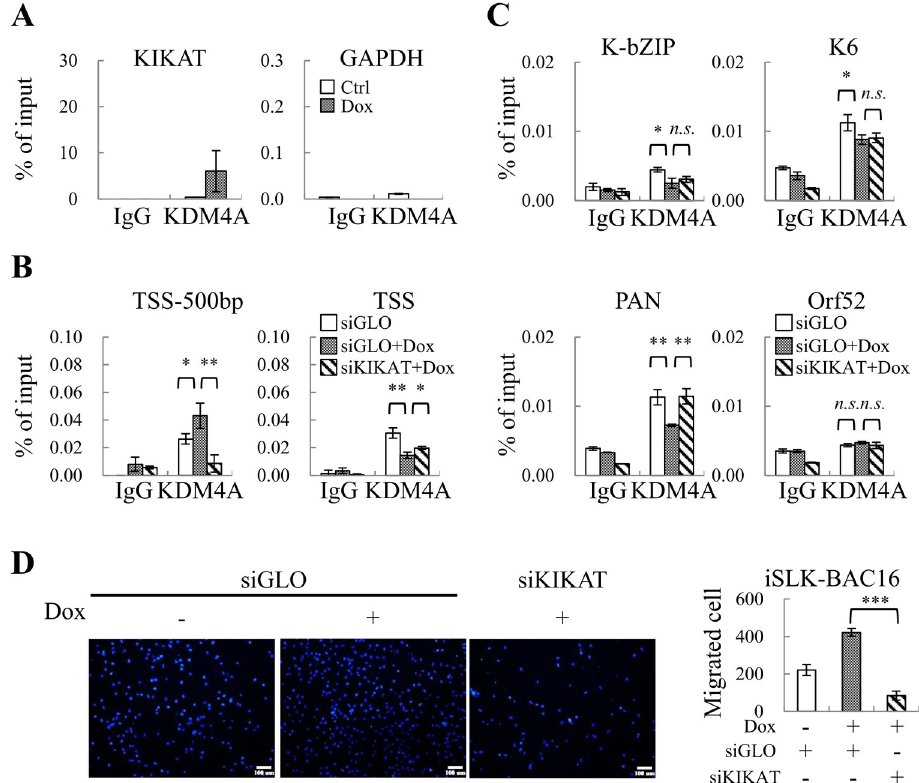
Fig 8. KIKAT/LINC01061 and KDM4A association in iSLK-BAC16 cells. (A) TCLs from control and Dox induced iSLK-BAC16 cells were used for RIP using KDM4A antibody or rabbit IgG as control. Copurified RNA from KDM4A and IgG IPs was assessed for KIKAT/LINC01061 enrichment by RT-qPCR. (B) Cells as described in Fig 7I were subjected to ChIP assay and the binding of KDM4A to the promoter of AMOT were analyzed by qPCR. (C) The enrichment of KDM4A on the promoter of several viral genes in cells described in Fig 7I were analyzed by qPCR. (D) iSLK-BAC16 cells were transfected with control siGLO or siKIKAT/LINC01061. After 6 hours, cells were re-seeded in 6-well plate and treated with 1 μ g/ml Dox for another 48 hours. in vitro transwell migration analysis was determined. Representative images (100x magnification) of transwell migration analysis (left panel). Scale bar: 100 μ m. Quantification of cell migration (right panel). Significance was determined by student’s t -test. � p < 0.05, �� p < 0.01, ��� p <